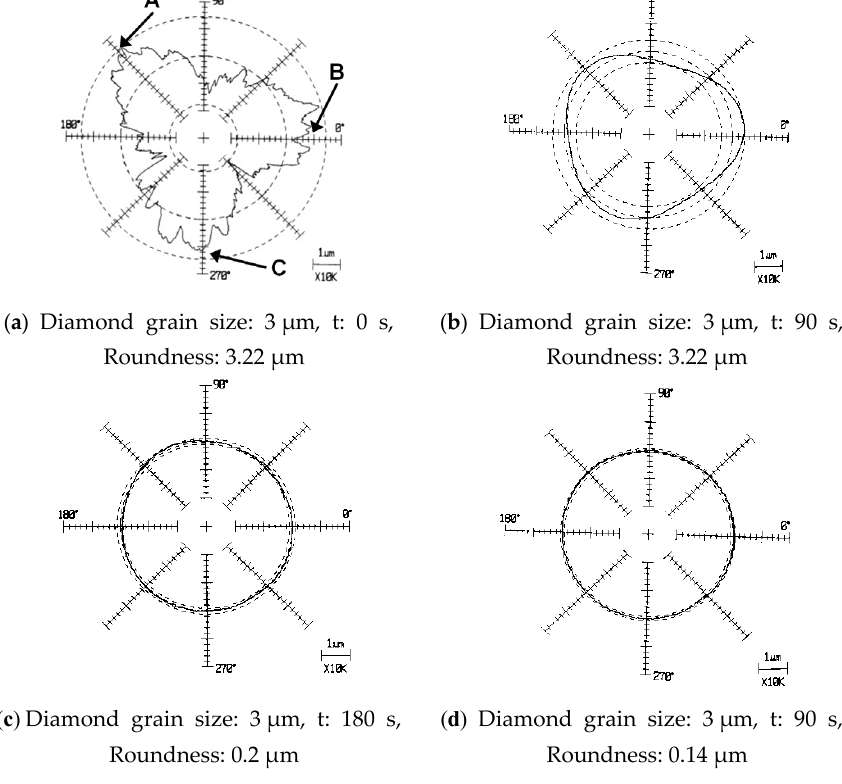
Figure 6. Roundness conditions before and after processing as it relates to processing time. (diamond paste weight: 200 mg, frequency of magnetic poles: 12 Hz).